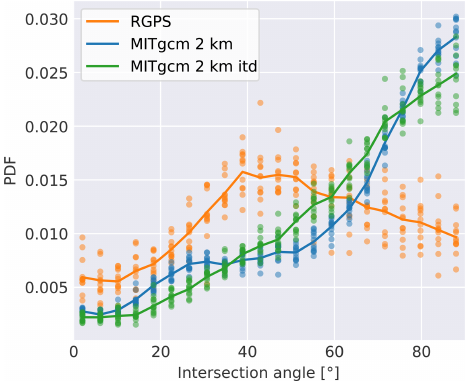
Figure 9. The PDF of intersection angles of LKFs in RGPS data and both simulations. The analysis is limited to pairs of LKFs that formed in the same time record and have a length larger 125km. In- dividual years are plotted as colored points and the multiyear mean is given as a solid